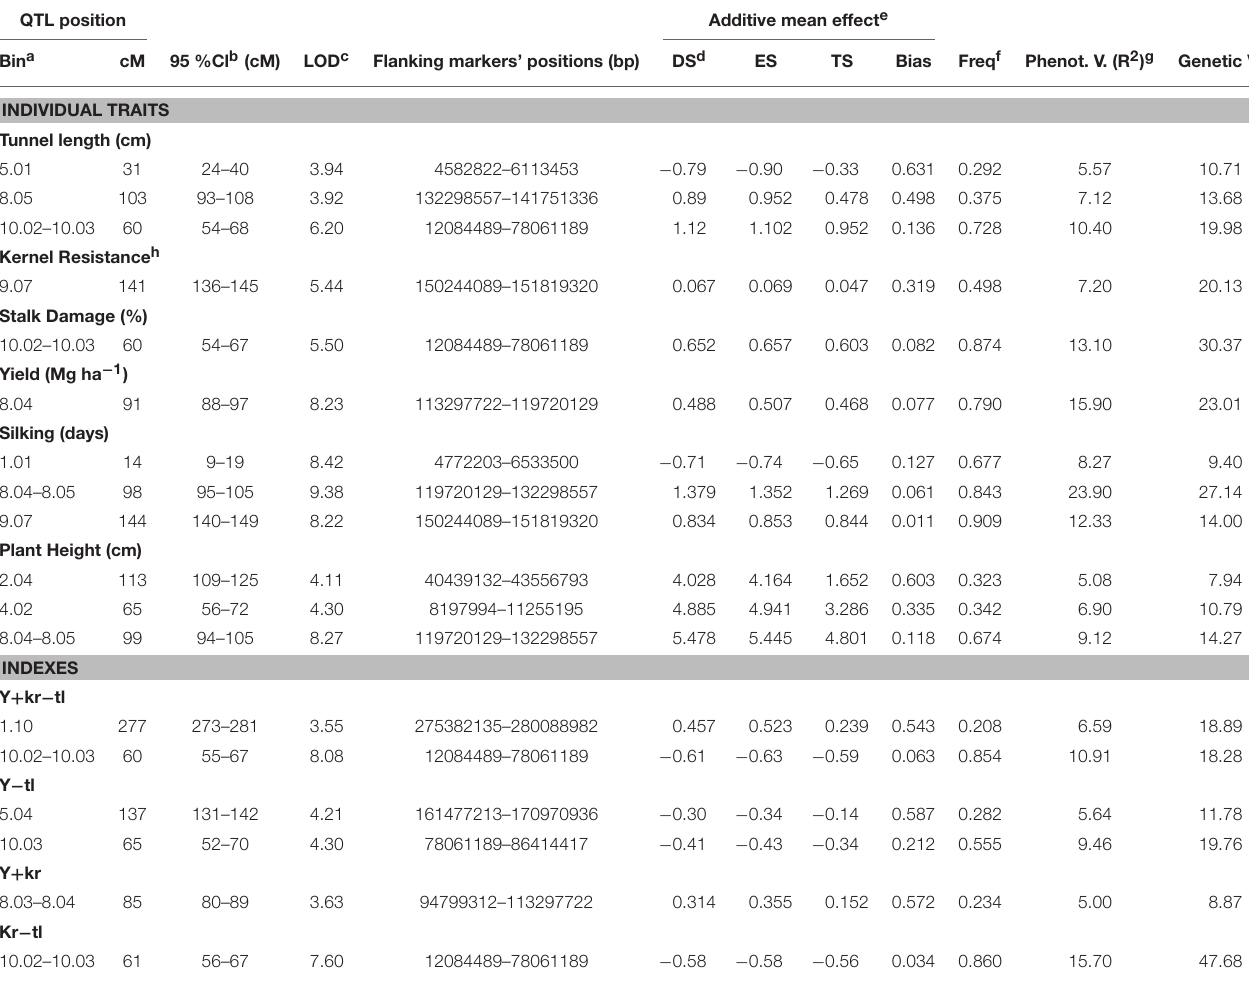
TABLE 3 | Summary of QTL mapped in the RIL population derived from A637 × A509 evaluated in a 2 year experiment under MCB infestation using a genetic map with an average interval between markers of 8.6 cM. QTL